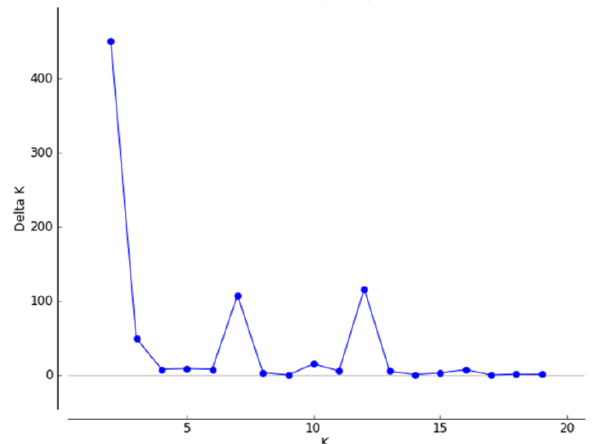
Figure 1. DeltaK plot showing the value of K (number of groups within population) that best fits the data.